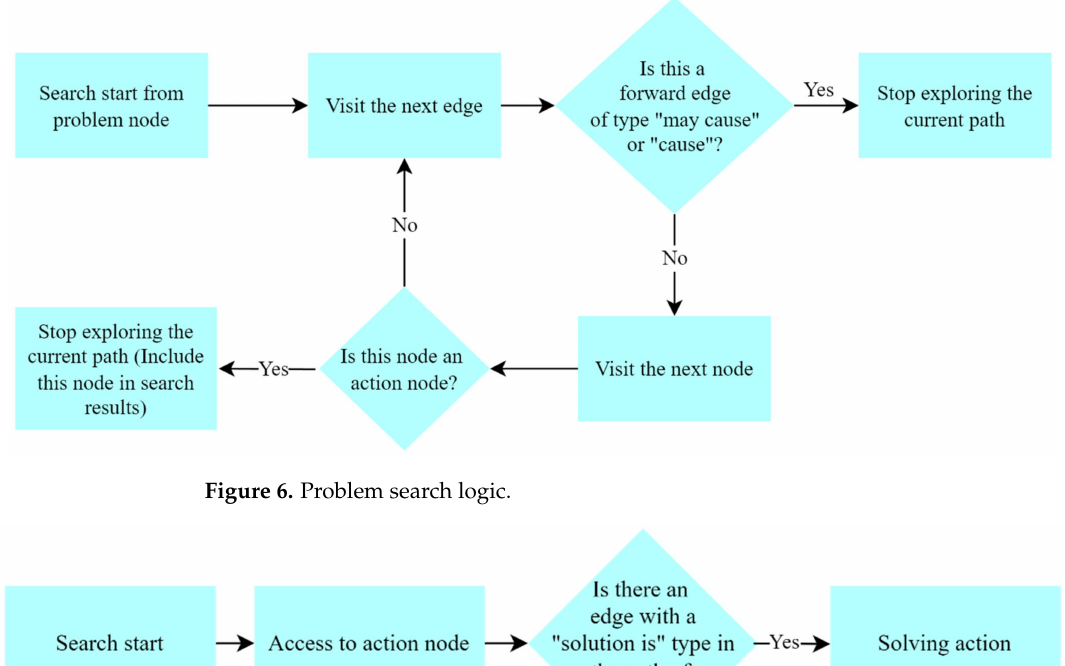
Figure 6. Problem search logic.